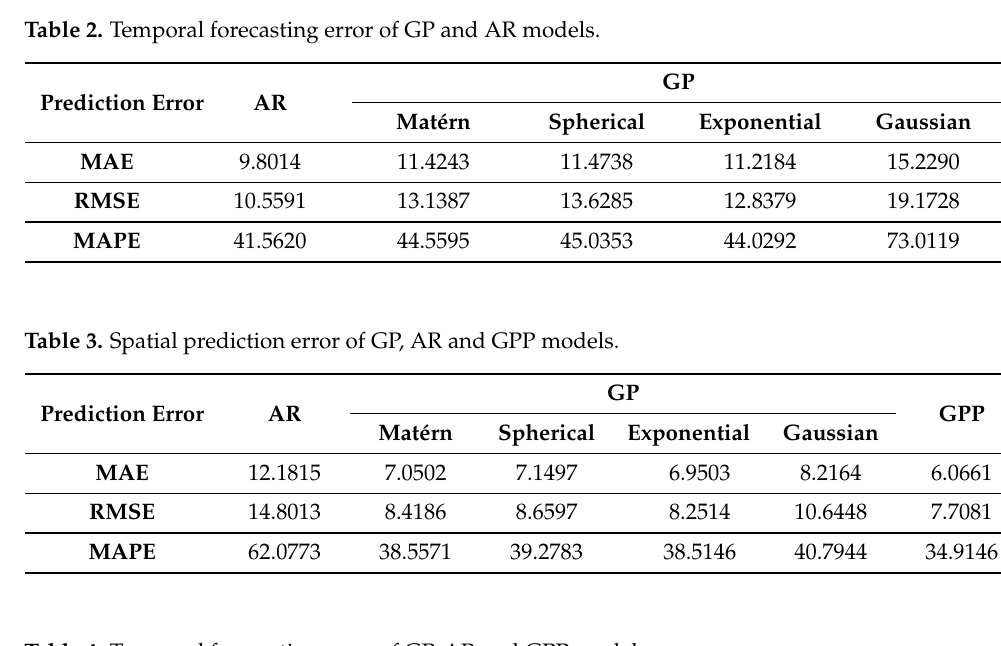
Table 4. Temporal forecasting error of GP, AR and GPP